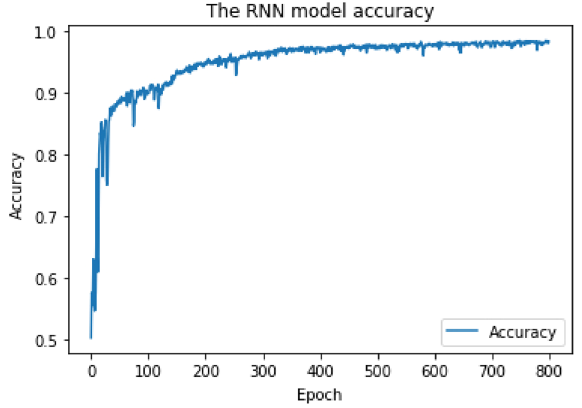
Figure 7. RNN training model achieved 95.7% accuracy for binary-class classification.